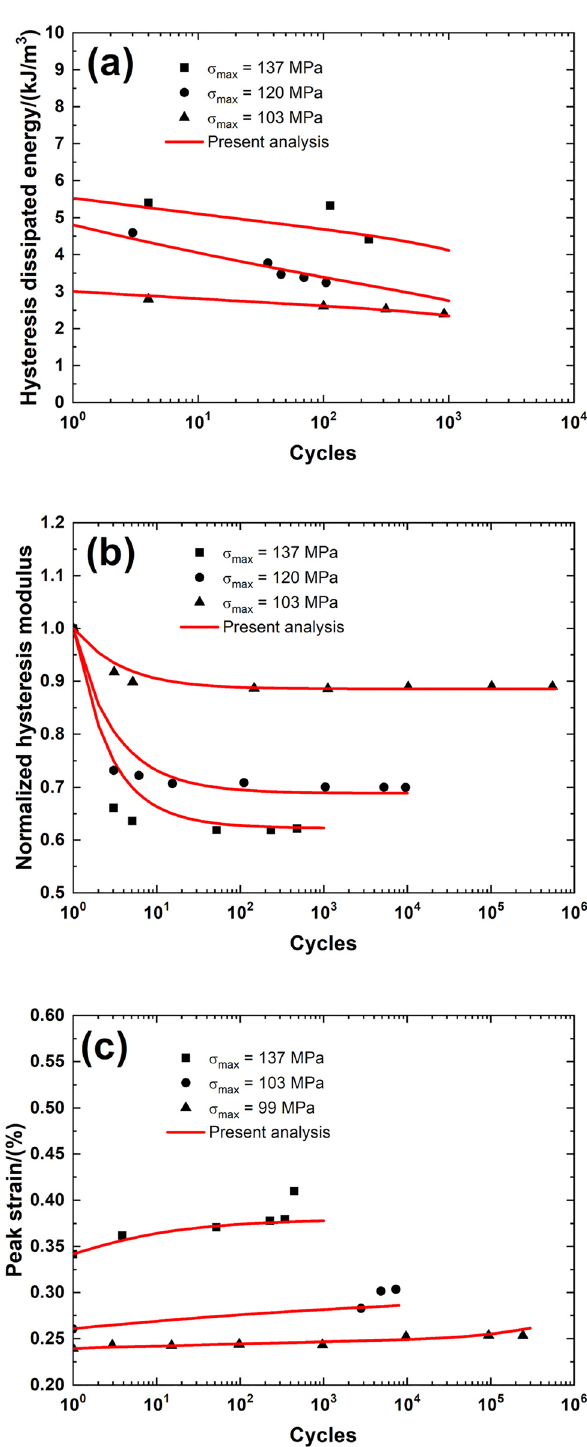
Figure 8: ( a ) The FHDE versus applied cycle curves, ( b ) the FHM versus applied cycle curves, and ( c ) the FPS versus applied cycle curves of cross - ply SiC/MAS composite under IF loading at 566°C in air